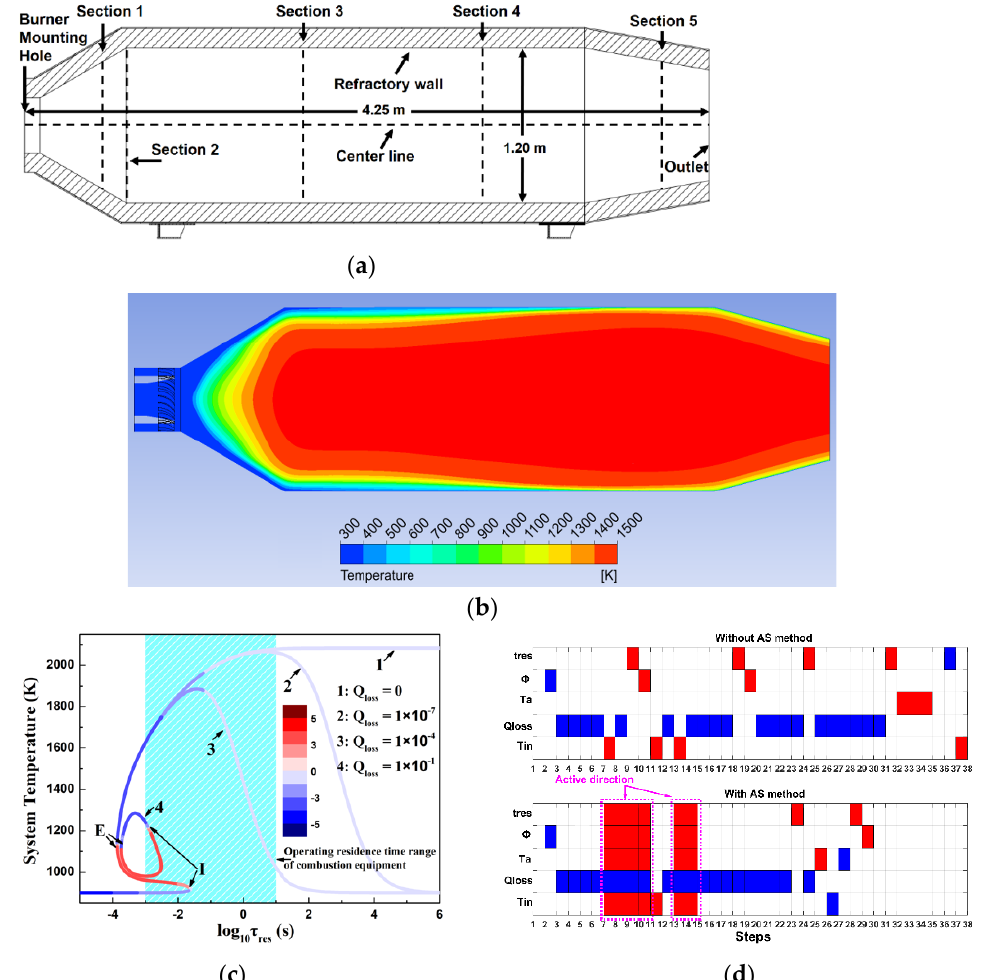
Figure 4. LCIG oscillating combustion in the Dagang incinerator system of China. ( a ) LCIG burner; ( b ) temperature contour from CFD; ( c ) temperature evolution calculated from PSR; (d) optimal regulation path of combustion parameters. Reprinted from Ref. [62].